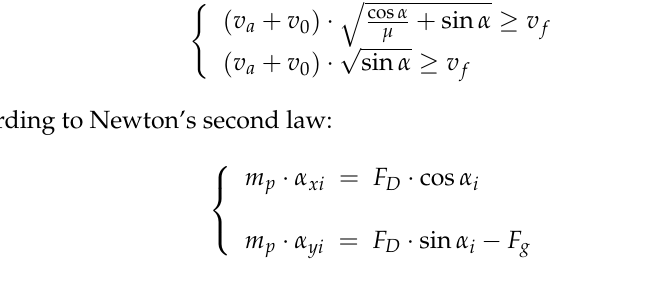
ticle left from the ground ( F N = 0, f = 0) was: